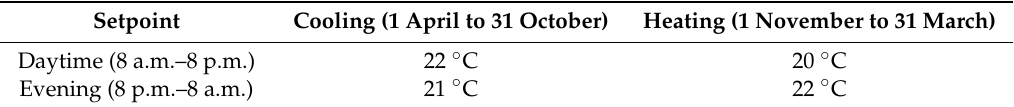
Table 4. Heat Pump Nominal Thermostat Settings.